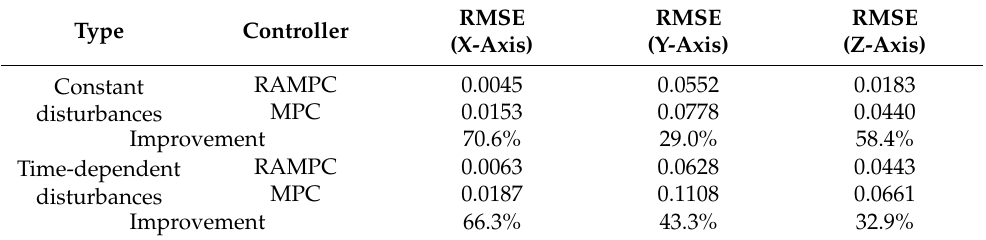
Table 2. Root mean square error of controllers under external